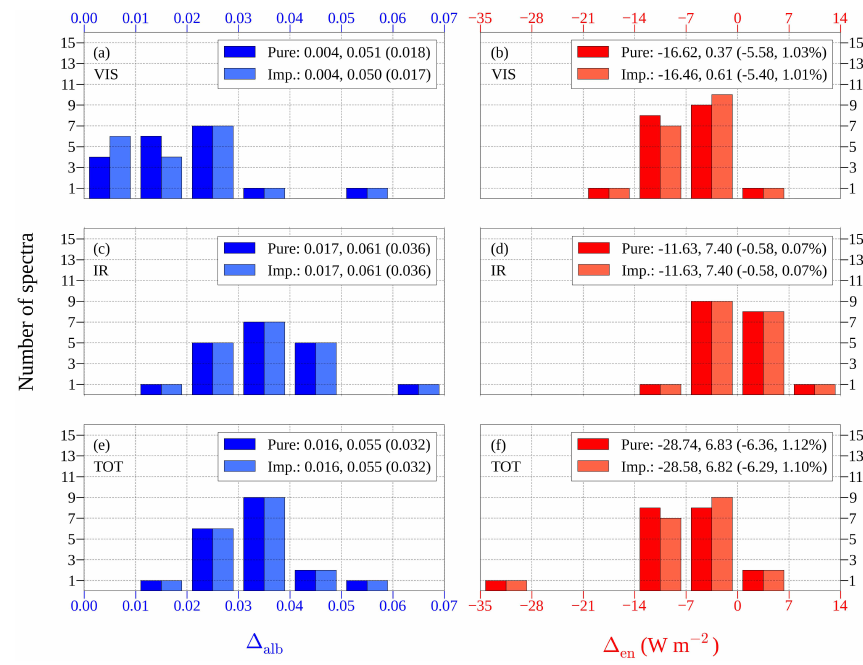
Fig. 10. Comparison between model and observations in terms of 1 alb (left panels) and 1 en (right panels). Three ranges of wavelengths are considered: the visible (VIS, 400–750nm) on the top, the infrared (IR, 750–2200nm) in the middle and the whole spectrum (TOT, 400–2200nm) on the bottom. Histograms show the number of spectra as a function of 1 values for pure snow and snow contaminated by impurities. The minimum and maximum 1 values are reported as well, along with the median (in brackets). For 1 en , the percentages of the energy absorbed by the snowpack corresponding to the median values are also